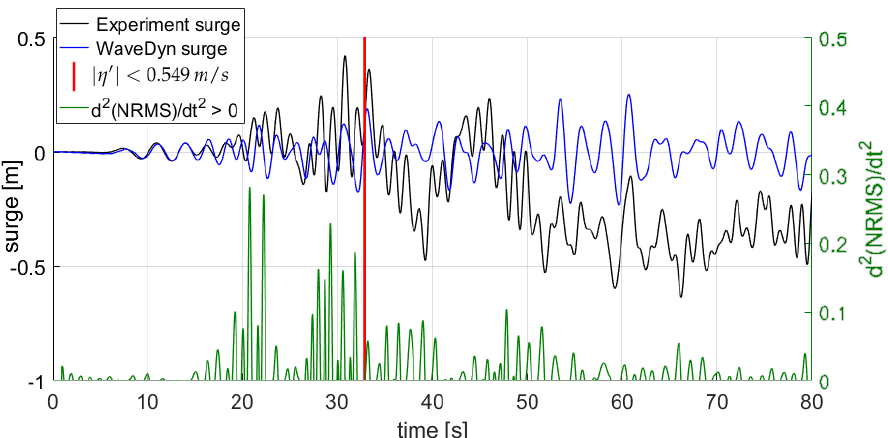
Figure 12. Estimation of the deviation point using the WaveDyn’s validity limit ( | identifies | η (cid:48) | < 0.549m/s) applied to an irregular extreme